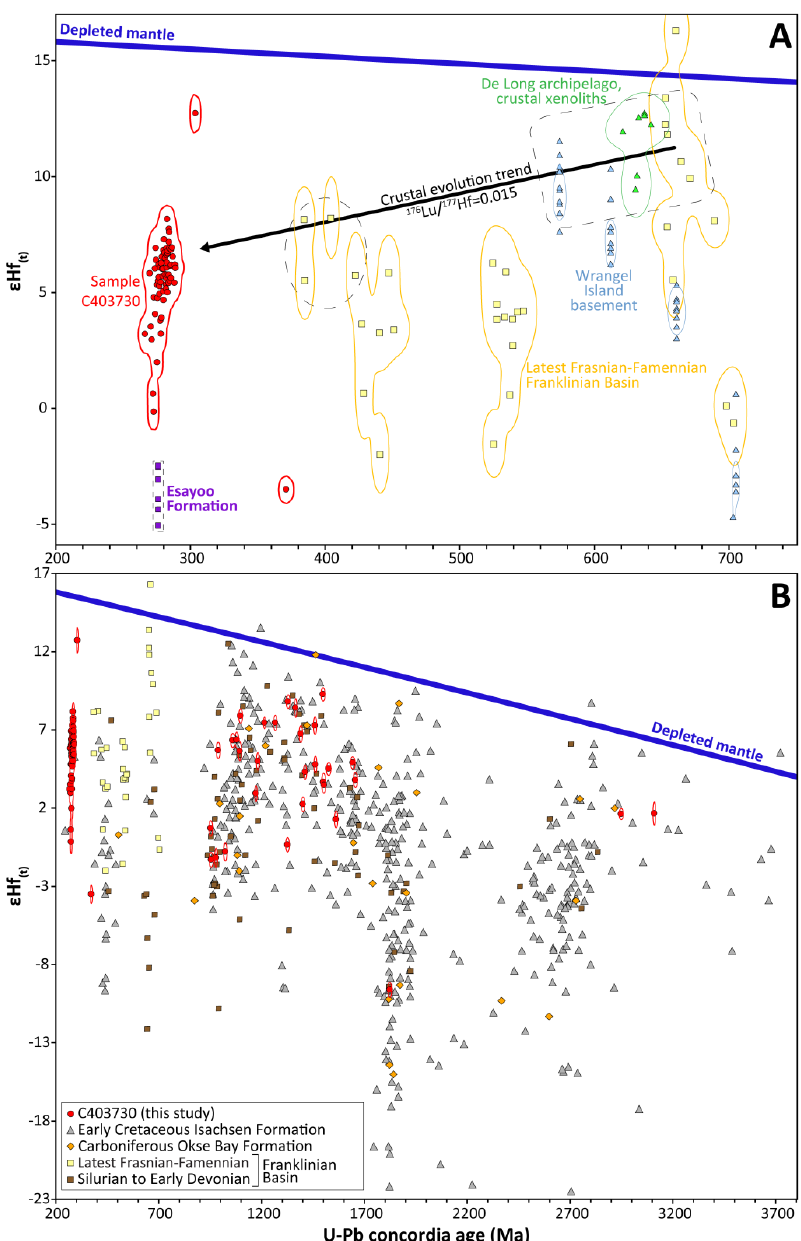
Figure 11. U – Pb age versus εHf (t) scatter plots showing data from sample C403730. ( A ) plot focusing on the dominant Permian age population in this sample; ( B ) plot showing the less abundant older grains. Data from the Esayoo Formation are whole-rock εNd (t) data from Morris [67] that are con- verted to approximate εHf (t) values using the εNd–εHf terrestrial array relationship of Vervoort et al. [103]. Detrital zircon U – Pb age and Lu – Hf isotope data from the Franklinian Basin [43,50], Okse Bay Formation [50] and Isachsen Formation [104] were reprocessed using U – Pb concordia ages. Analyses with U – Pb ages >10% discordant are not shown. Detrital zircon U – Pb age and Lu – Hf iso- tope data from basement rocks on Wrangel Island are from Gottlieb et al. [105]. Detrital zircon U – Pb age and Lu – Hf isotope data from crustal xenoliths from basalts on the De Long Islands are from Akinin et al. [106]. The thin bands surrounding data points are two-dimensional probability distri- butions drawn from the data and their respective analytical uncertainties in R using code modified from Sircombe [107]; they are drawn at the 2s confidence level. The depleted mantle trend is drawn assuming a present-day composition of 176 Lu/ 177 Hf = 0.0384 and 176 Hf/ 177 Hf = 0.28325 [108].